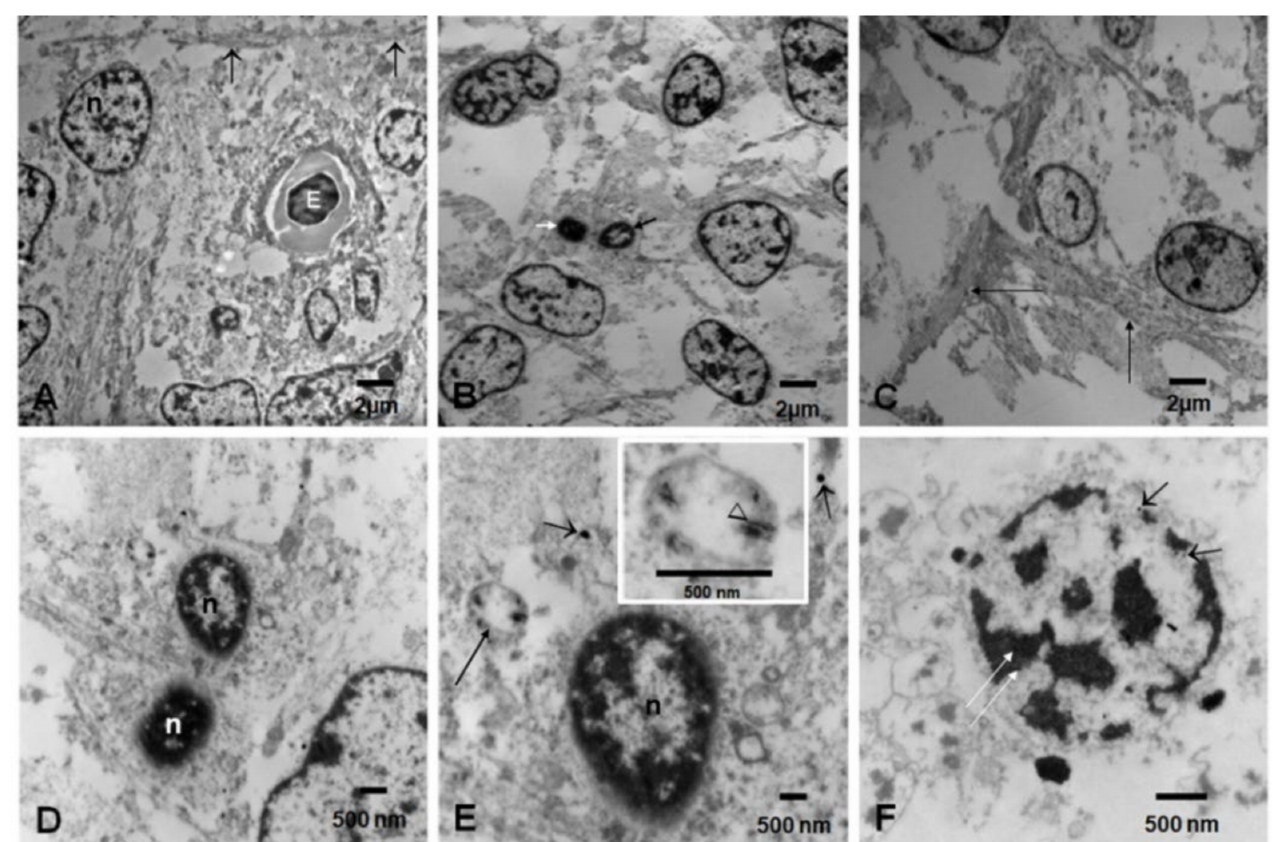
Figure 6. Electron microscopy of brain cortical cells. ( A ). Electron microscopy of cortical areas showed capillaries occupied by erythroblastic cells (E) with large nuclei, surrounded by primitive neural cells and horizontal fibers (arrows). ( B ). A number of neural primitive cells show large lobulated, medium size, and small nuclei (small black and white arrows). ( C ). Bundles of fibers (arrows) can be seen crossing the primitive neuropil. ( D ). Two cells with small distinct nuclei- the pyknotic one marked with a white (n) are conspicuous because of their cytoplasmic features seen in ( E ). ( E ). The same cell as in ( D ) contains mitochondria with numerous nanoparticles (long arrow) and free cytoplasmic NPs (short arrows). Insert: the particulate nanomaterial exhibits rod and spindle shapes (arrowhead). ( F ). A primitive neuronal nucleus with NPs free (short black arrows) in the nuclear matrix and associated with heterochromatin (long white